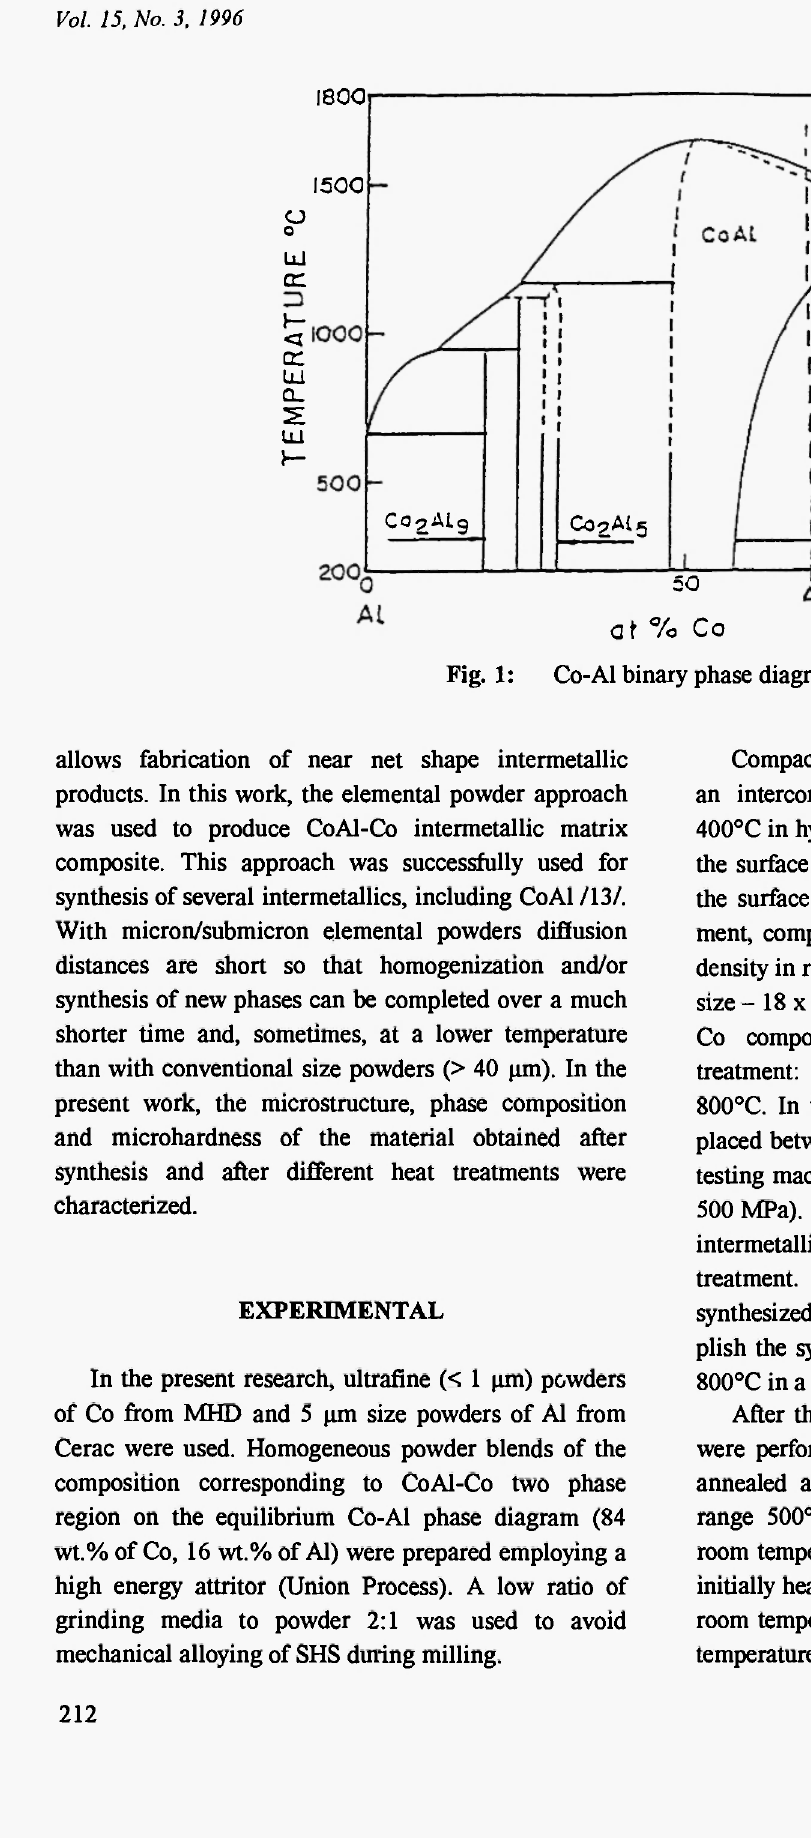
C02 A1 -9 Co 2 50 at % Co Fig. 1: Co-Al binary phase diagram.